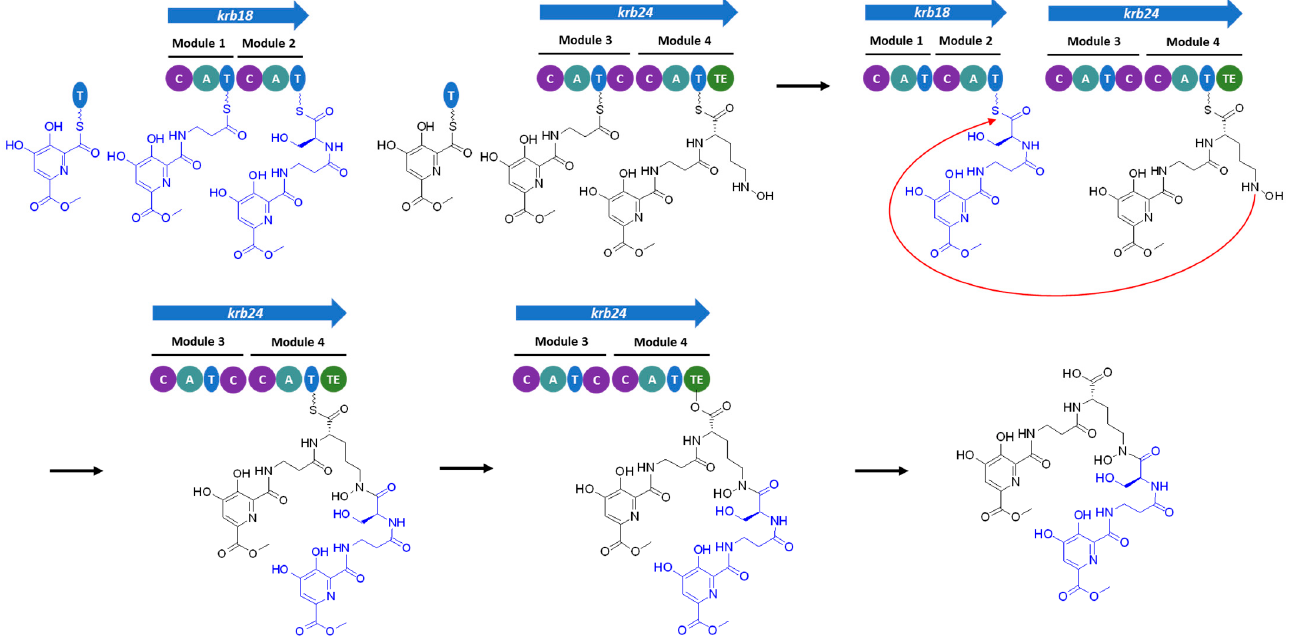
Figure 4. Proposed non-canonical assembly line of kribbellichelins A–B. Two dipeptides are independently synthesized by the two NRPSs, followed by amide bond formation between the nitrogen at the δ carbon of N5-OH-Orn and the carboxylic group of Ser. Both NRPSs (Krb18 and Krb24) contain two modules including the expected conden- sation (C), adenylation (A), and thiolation (T) domains. The substrate specificity analysis of the A domains performed with antiSMASH and PRISM suggest incorporation of β -Ala,